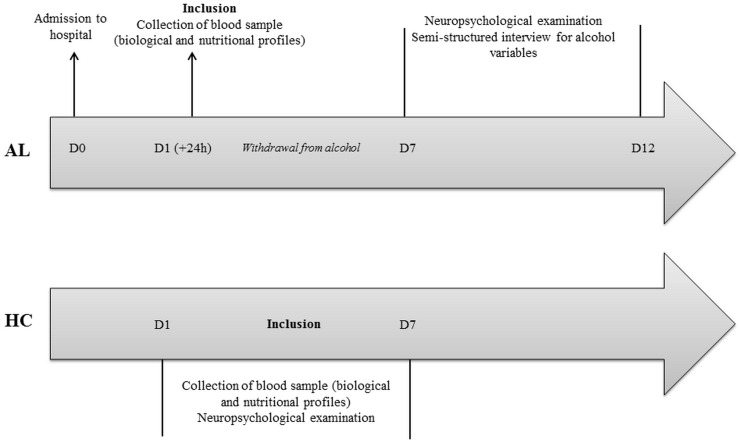
Design of the study depicting the sequence of alcohol, biological and nutritional measures as well as neuropsychological examination in alcoholic patients (AL) and healthy controls (HC).